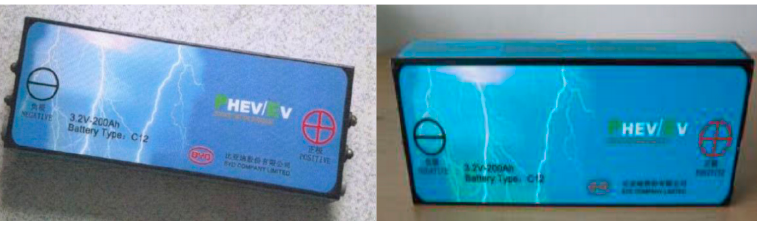
Figure 1. Prismatic LiFePO 4 cells.